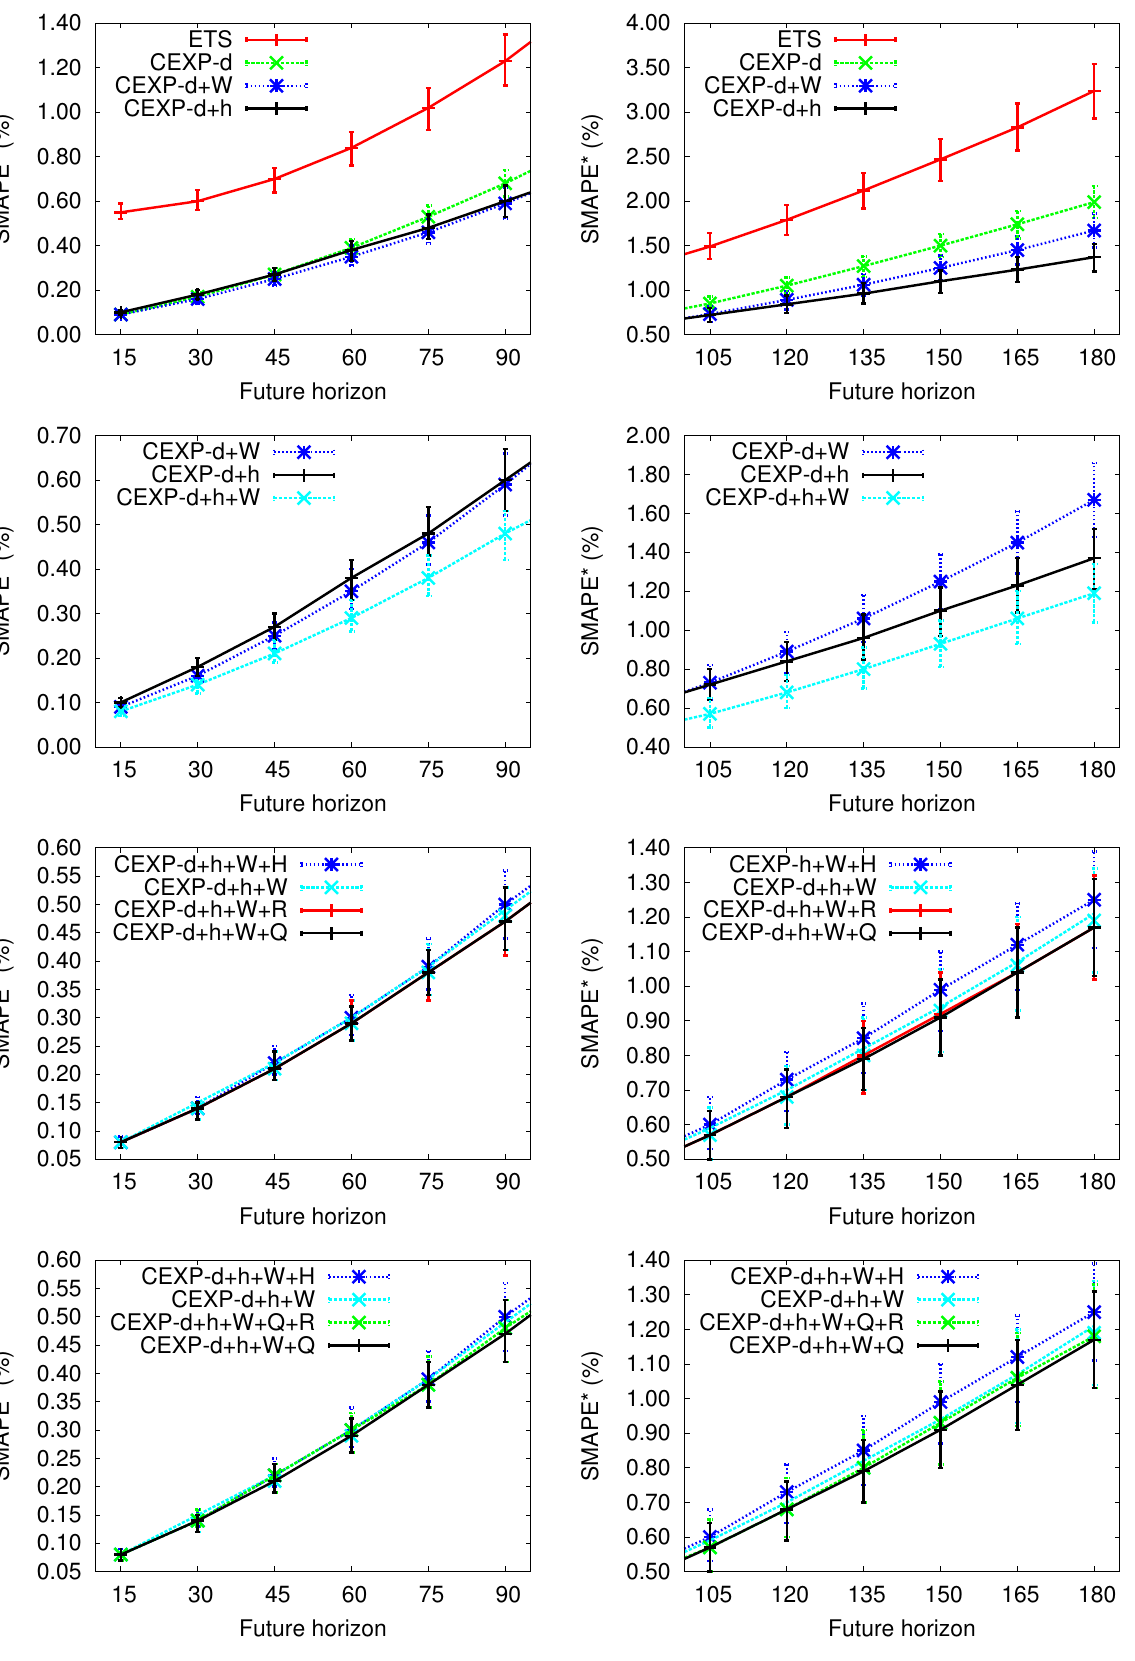
Figure 6. SMAPE (cid:63) error plot with 99% confidence interval of each of the Z = 12 future horizon predicted values (from 15 min forecast to 180 min